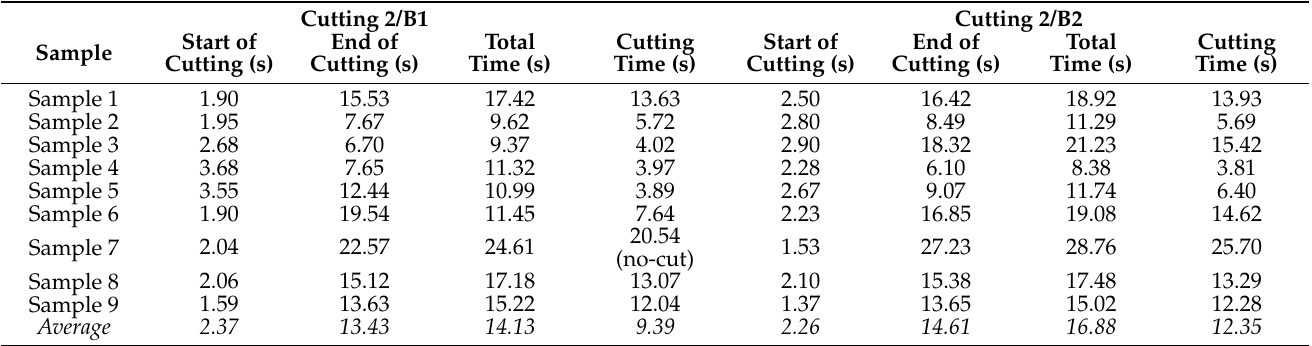
Table 4. Experiment results—cutting process time parameters (“B” pillars, 9 samples, 2 measurements